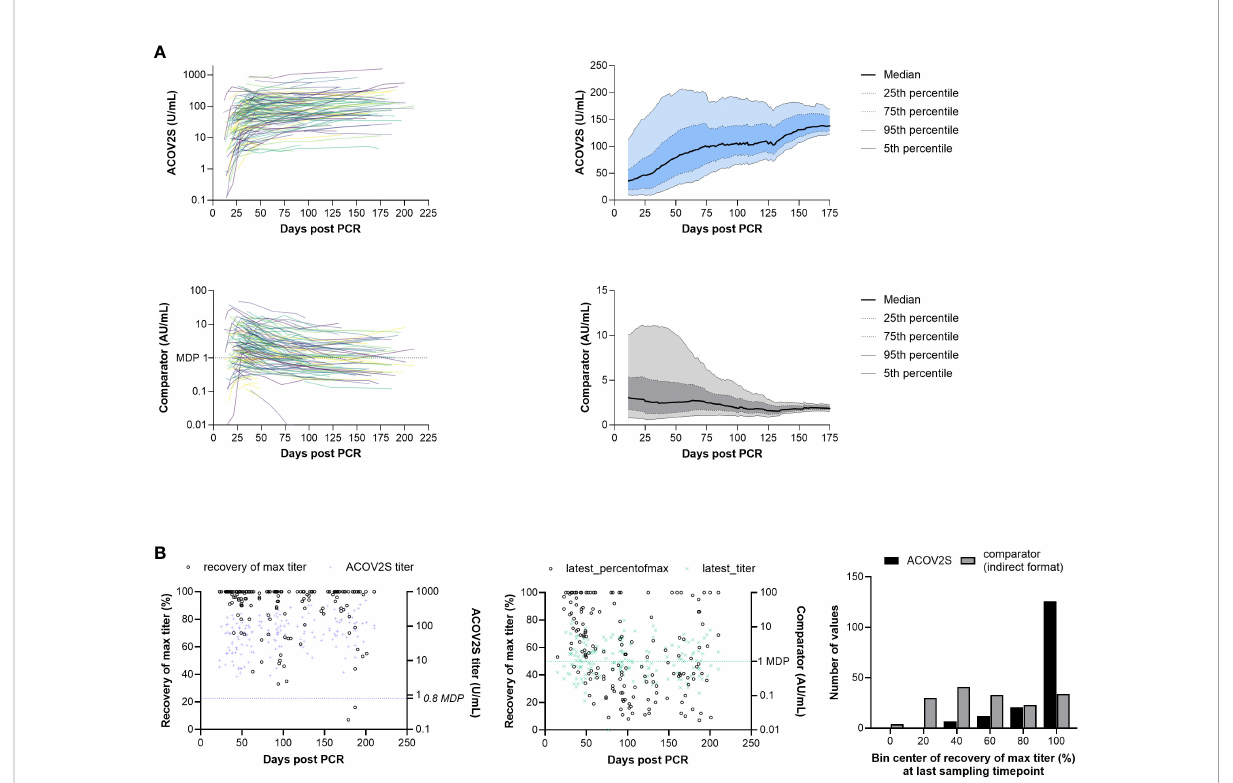
FIGURE 4 RBD titer dynamics. (A) Spaghetti and smoothened median curves for RBD titers over time for the ACOV2S and comparator assay, and (B) relative recovery at the last sampling timepoint for the ACOV2S and comparator assay (absolute titer values at the last sampling timepoint are plotted in color [right y-axis] and relative recovery is plotted in black [left